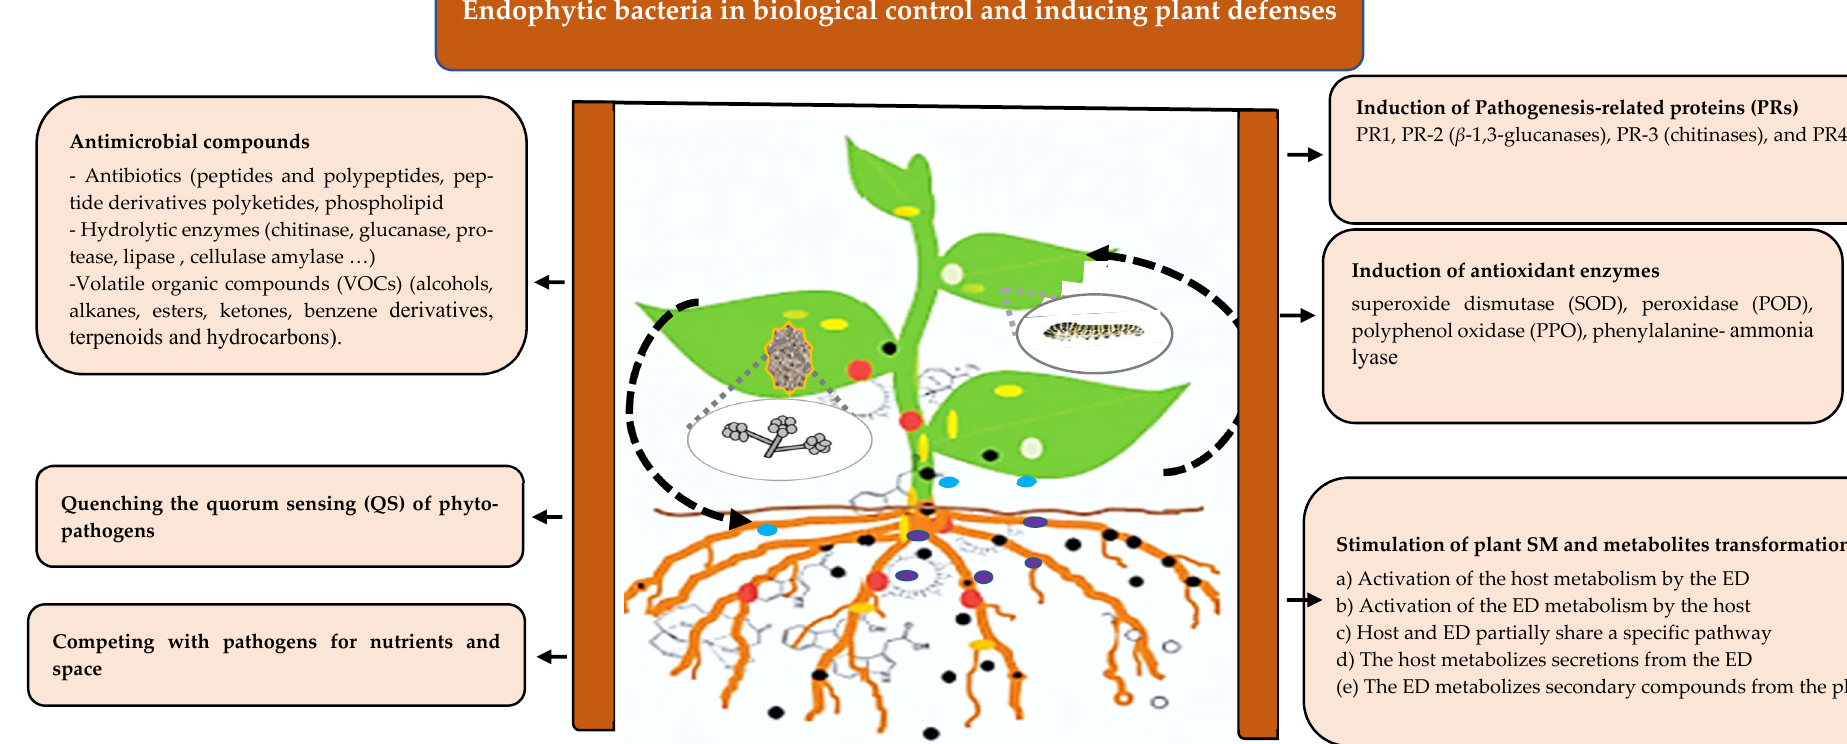
Figure 1. Mechanisms of endophytic bacteria in plant protection against biotic stressors. Endophytic bacteria may protect their host by direct action, producing antimicrobial compounds including antibiotics, hydrolytic enzymes, and VOCs, or indirectly, increasing plant defenses inducing pathogenesis-related proteins, antioxidant enzymes, and stimulation of the secondary metabolisms of both the host and the bacterial endophyte. ED: endophyte; SM: secondary metabolism.